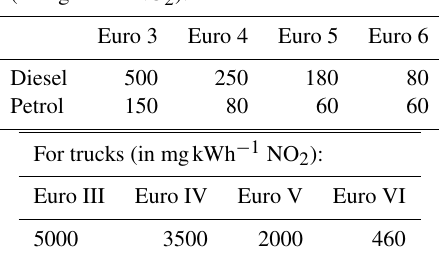
Table 2. European emission standards for NO x emissions (Umwelt- bundesamt,